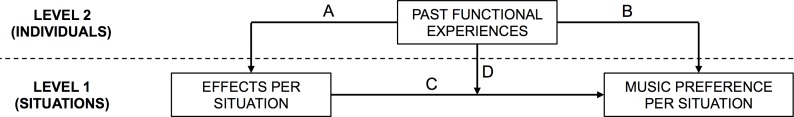
Multilevel model of the proposed relationships between past functional experiences, the effects of music listening, and the strength of music preference.